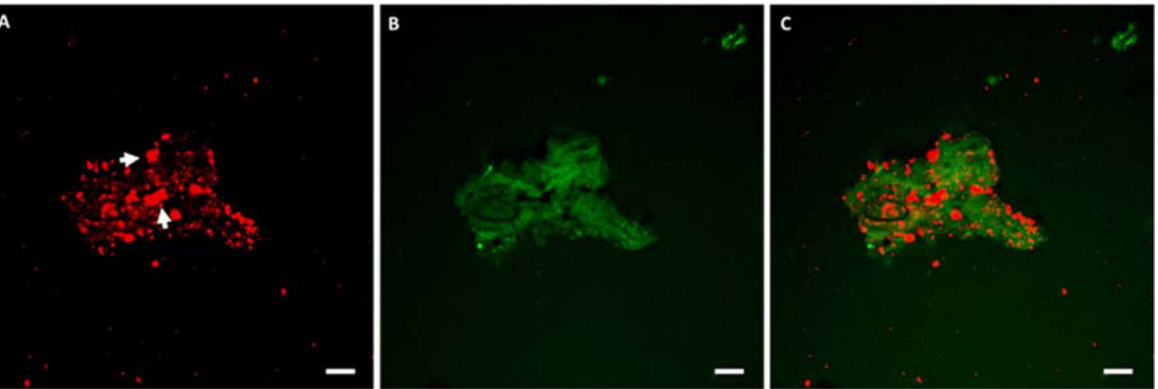
Figure 3. CLSM of a protein aggregate in urea/DDT buffer. Separate fluorescent channels for fat ( A ) and protein ( B ), merged channels in panel ( C ). Arrowheads indicate non-globular fat. Bars are 10 µm.